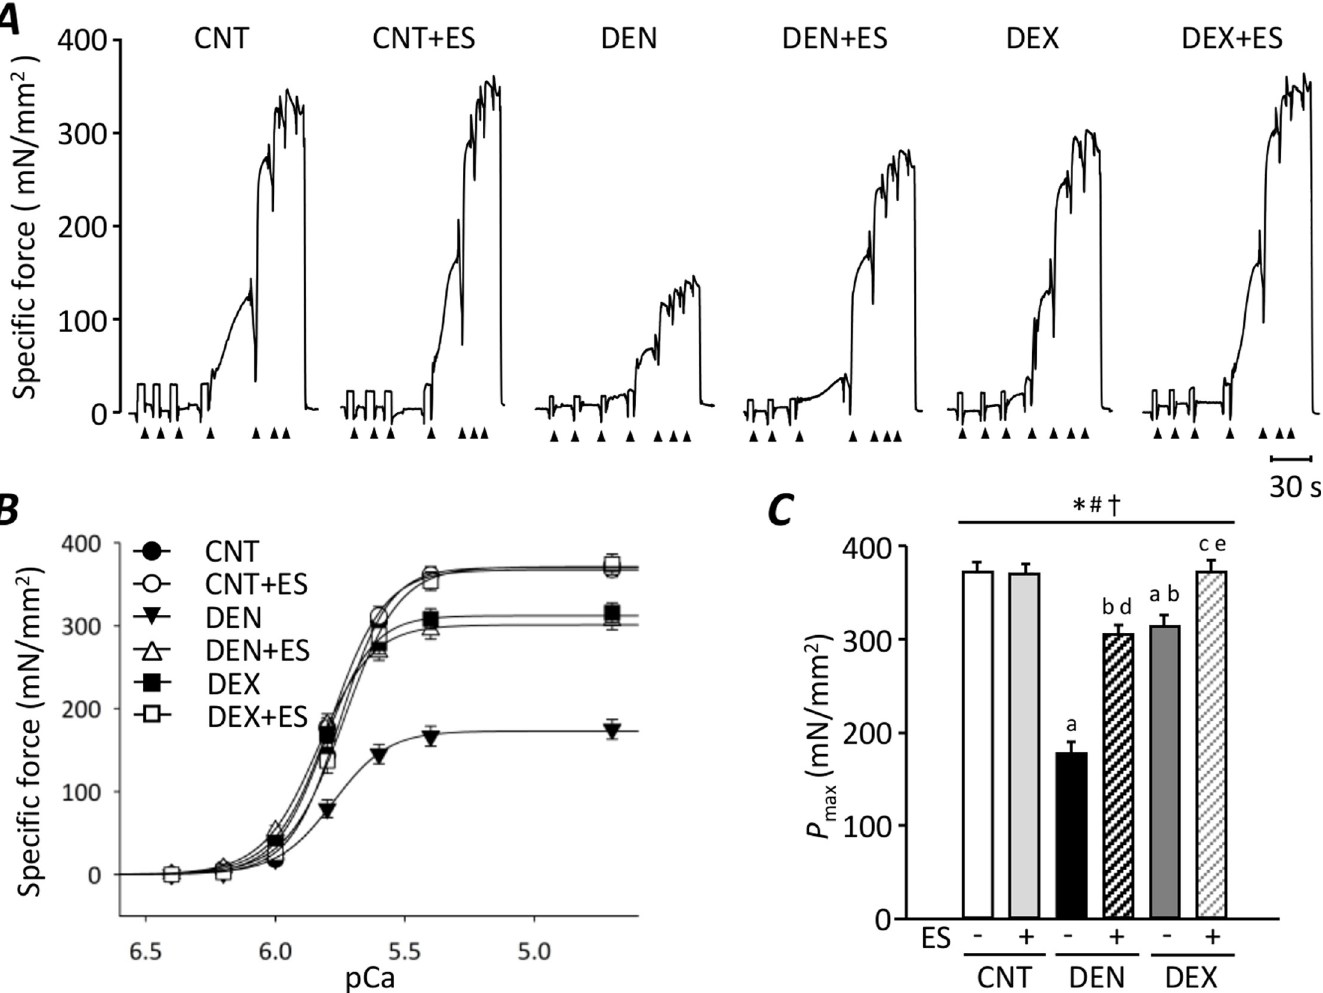
Fig 2. Myofibrillar dysfunction was more marked in DEN than in DEX rats. Representative original records of Ca 2+ -activated force in chemically skinned fibers from gastrocnemius muscles of control (CNT), denervation (DEN), and dexamethasone (DEX) rats with or without neuromuscular electrical stimulation (ES) training (A) . Fibers were exposed to solutions at progressively higher free Ca 2+ concentration: pCa 6.4, 6.2, 6.0, 5.8, 5.6, 5.4, and 4.7. Specific force-frequency relationship (B) and the maximum Ca 2+ -activated force ( P max ) (C) . Data presented as mean and SEM from 20–25 fibers per group. Statistical significance was set at P < 0.05: main effect of � treatment (i.e., DEN and DEX) and # ES; † interaction of treatment and ES; difference versus a CNT, b DEN, c DEX, d CNT+ES, and e DEN+ES.